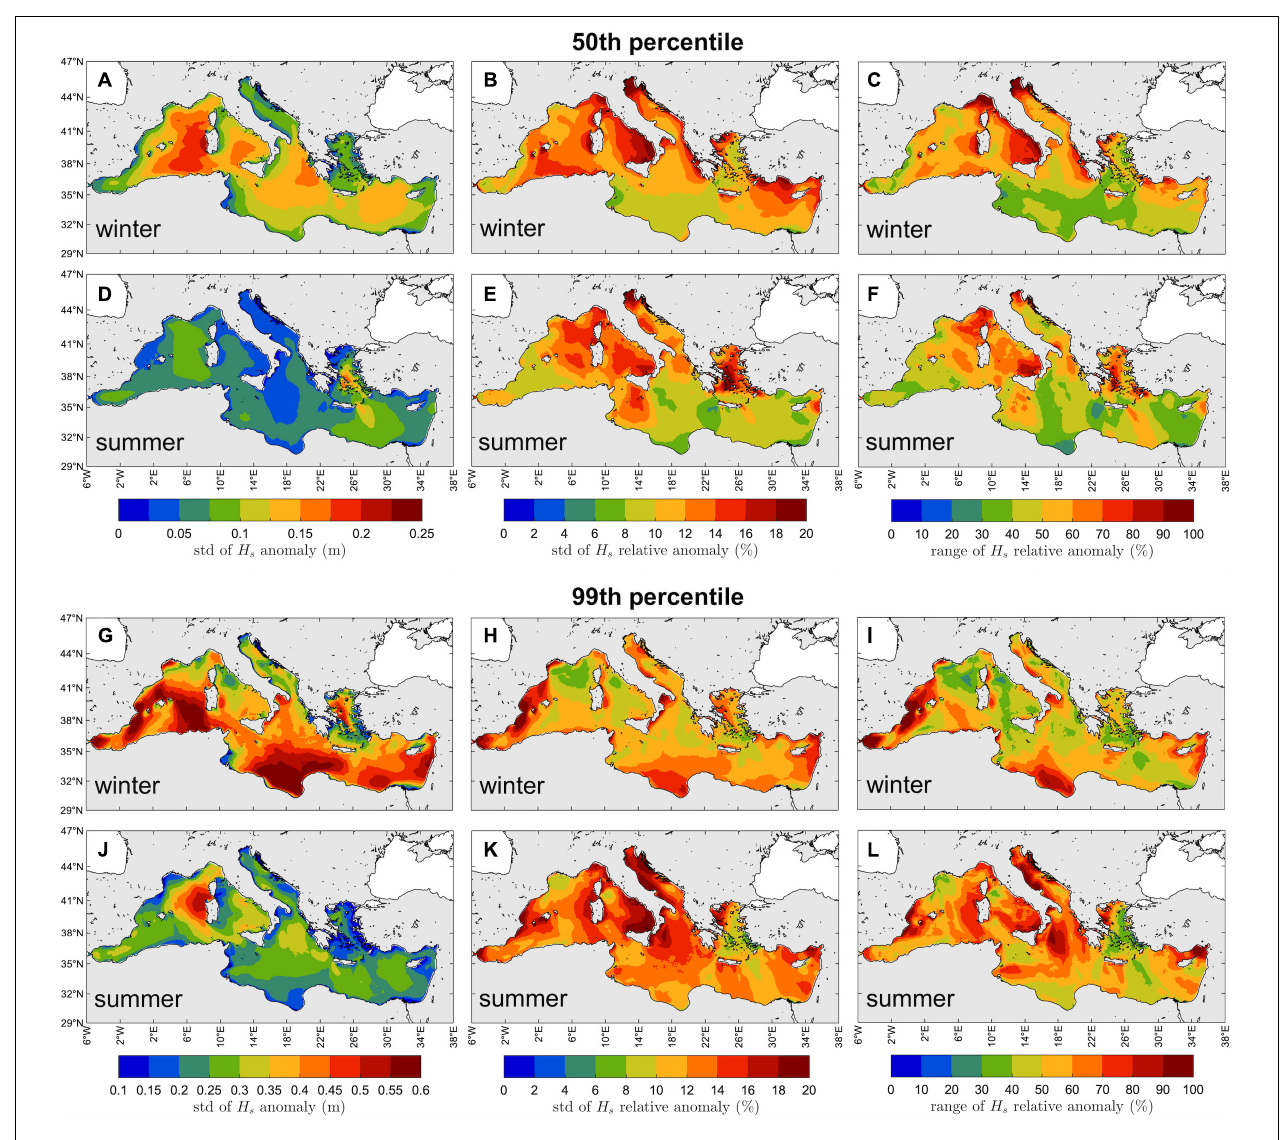
FIGURE 7 | Inter-annual variability of the typical [50th percentile, panels (A–F) ] and extreme [99th percentile, panels (G–L) ] wind-wave climate. Standard deviation (std) of the H s anomaly [panels (A,D,G,J) ], standard deviation of the relative anomaly [panels (B,E,H,K) ] and range [maximum-minus-minimum; panels (C,F,I,L) ] of the relative anomaly of the winter (NDJFM) and summer (JJA) 50th and 99th percentile of H S (1981–2019), with respect to the yearly-averaged winter and summer 50th ( Figure 4 ) and 99th ( Figure 5 ) percentile of H S ,